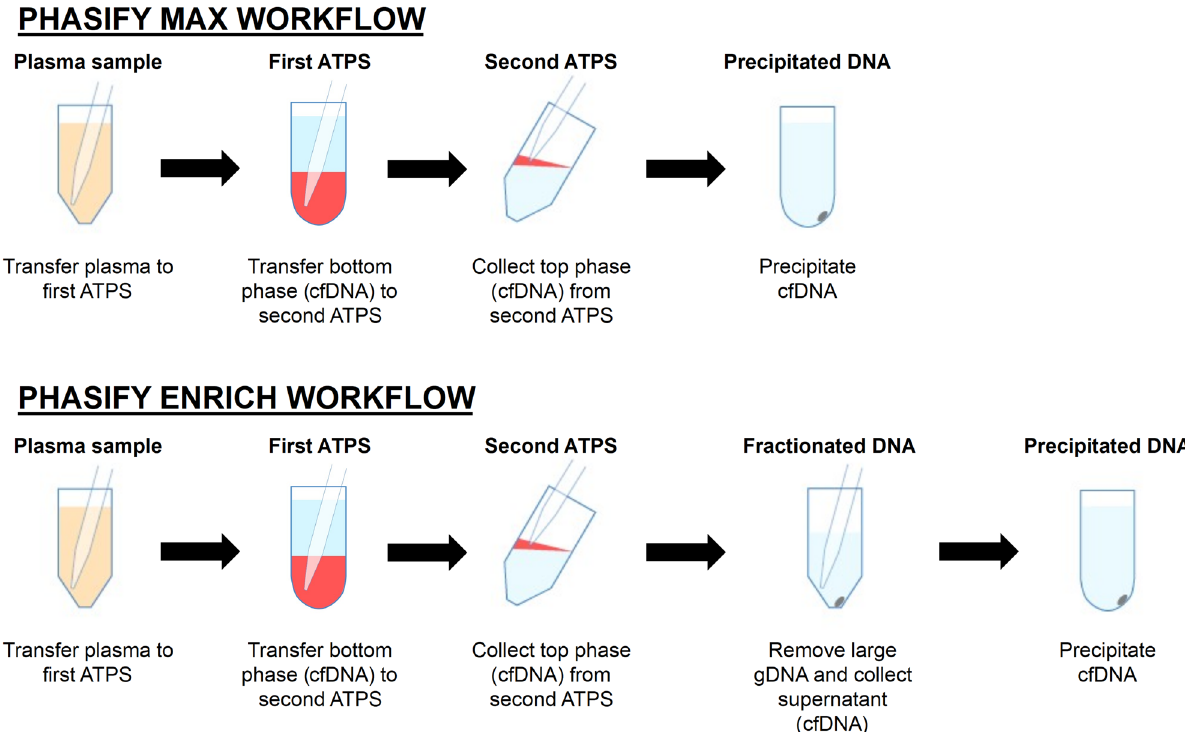
Figure 1. Schematic of DNA isolation process with PHASIFY MAX and PHASIFY ENRICH. The PHASIFY method uses serial two-phase liquid extraction systems to isolate and purify cfDNA from a starting plasma sample. In the first ATPS, DNA partitions to the bottom phase (red), which is then extracted and transferred to a second ATPS. After phase separation, the DNA partitions to the top phase (red), which is then extracted. In the PHASIFY MAX workflow, all extracted DNA undergoes DNA precipitation. In the PHASIFY ENRICH workflow, the extracted DNA is first mixed with a fractionation solution to remove contaminating DNA and enrich the sample with potential tumor cfDNA. The enriched sample then undergoes DNA